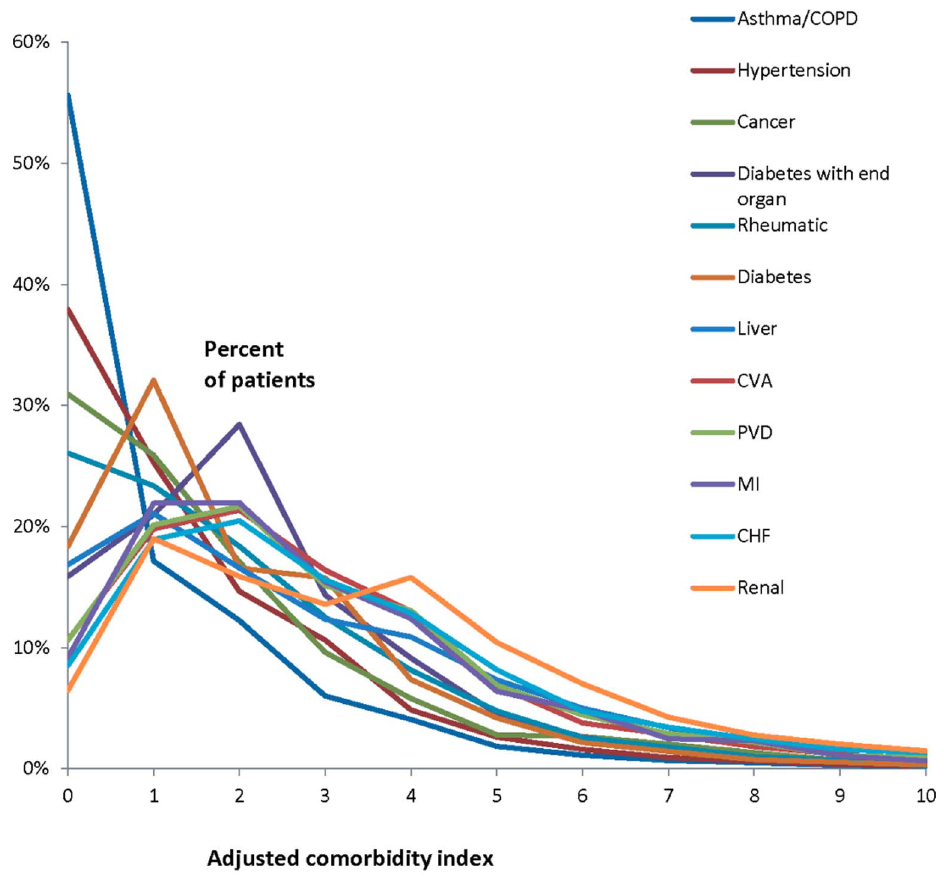
Figure 1. The y axis is the proportion of patients with a given chronic disease according to the adjusted comorbidity index. The x-axis is the adjusted comorbidity index found by subtracting the weight of each disease from the patient’s comorbidity index for those patients with the stated disease . Thus, a patient with an adjusted comorbidity index of 0 has only that chronic disease.